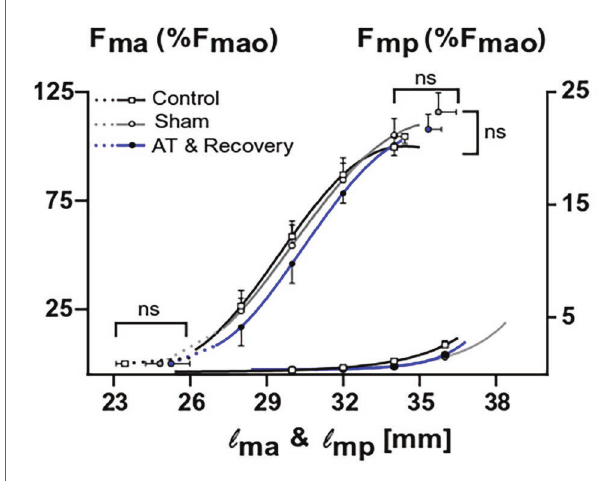
FIGURE 7 | The combined effects of aponeurotomy plus recovery from aponeurotomy on the muscle active and passive length-force characteristics. Normalized active and passive muscle forces ( F ma and F mp , respectively) as a function of muscle length (l m ) are plotted in continuous lines. Extrapolated forces, ranging from the lowest measured muscle lengths to the estimated muscle active slack length, are plotted as dashed lines. After aponeurotomy plus recovery, active muscle force and length-force characteristics were similar to those of control GM. The passive length-force curve of the aponeurotomy plus recovery group was also similar to that of the control group. This indicates that after 6 weeks of recovery, the intervention had no effect on the muscle length range of active or passive force exertion, neither had the aponeurotomy plus recovery an effect on the force generating capacity. Two-way mixed ANOVA (with repeated measurements for muscle length) was used to check if (normalized) muscle force was similar between groups. Additionally, a one-way ANOVA was used to check for differences between the optimum muscle force, optimum muscle length, and slack length. All values are presented as mean and either plus or minus SEM; control n = 10, sham n = 6, AT & recovery n =